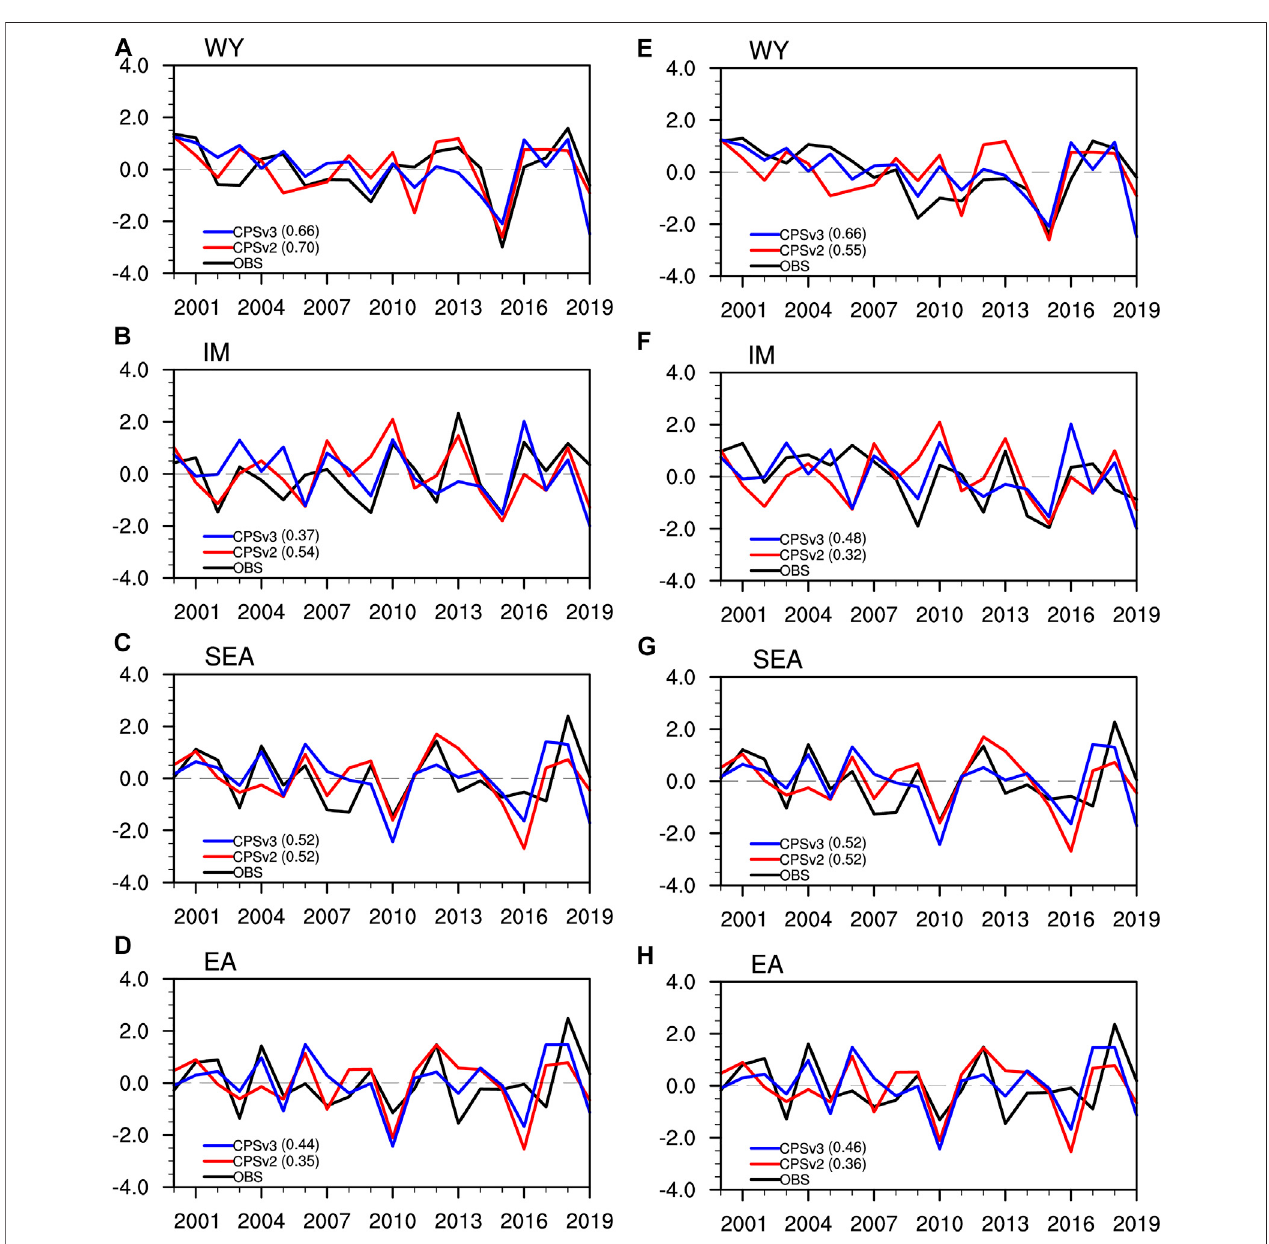
FIGURE 4 | Time evolution of dynamical ASM indices: (A,E) WY, (B,F) IM, (C,G) SEA, and (D,H) EA monsoon indices. Left panels: observation is ERA5 data; right panels: observation is NCEP2 data. (The decimals shown in brackets are the temporal correlation coef fi cients between observation and predictions).